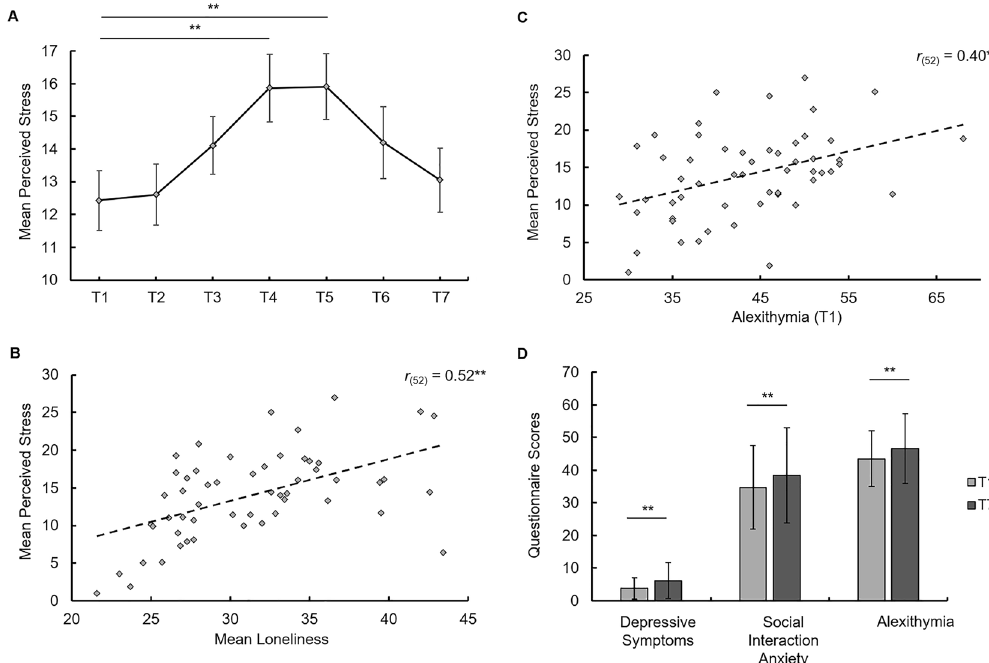
Figure 1. Perceived stress significantly changed over time and peaked in months four and five of the observation period ( A ). Mean perceived stress positively correlated with mean loneliness ( B ) and alexithymia ( C ) at study entry. Depressive symptoms, social interaction anxiety and alexithymia significantly increased after 6 months ( D ). Error bars show the standard error of the mean. ** p < 0.01, T1–T7, first to seventh